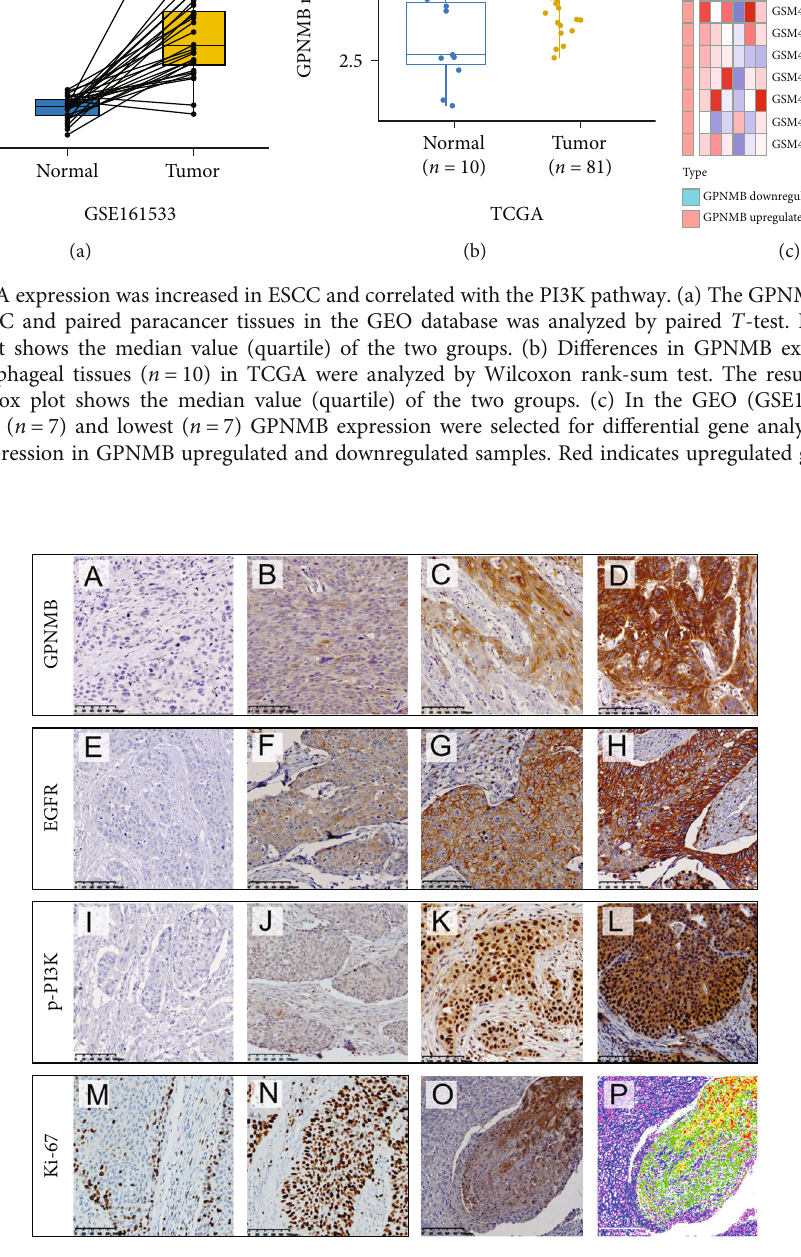
Figure 2: IHC of GPNMB, EGFR, p-PI3K, and Ki-67 in ESCC. (a) to (d) represent colourless, weak, medium, and strong colours of GPNMB, respectively; (e) to (h) represent colourless, weak, medium, and strong colours of EGFR, respectively; (i) to (l) represent colourless, weak, medium, and strong colours of p-PI3K, respectively; (m) and (n) represent the images of low and high expressions of Ki-67, respectively; (p) represents the image after Image-Pro Plus processing (red indicates the range of strong staining, yellow indicates the moderately stained range, and green indicates the weakly stained range); (o) represents the original